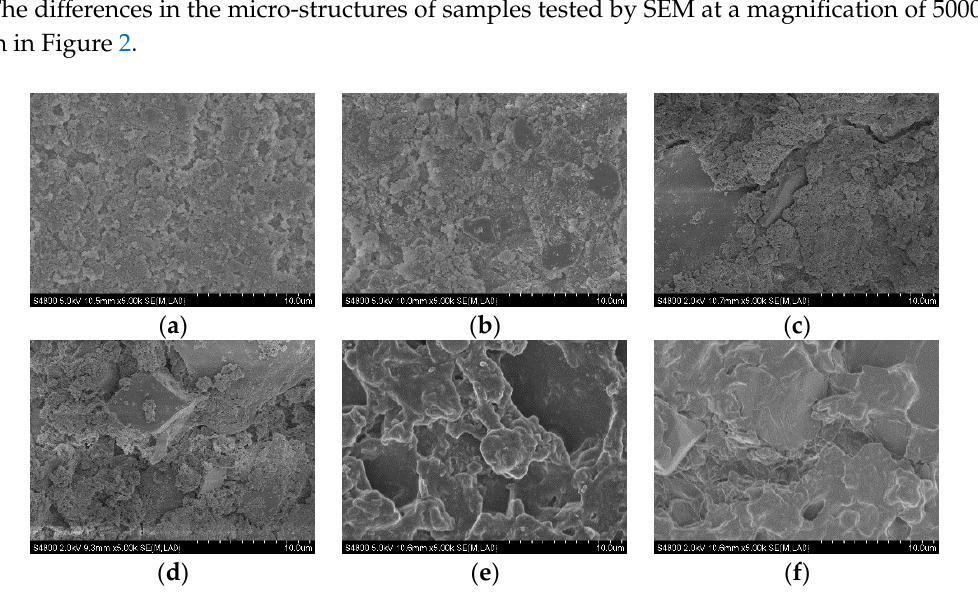
Figure 2. Morphology of samples using scanning electron microscopy (SEM), 5000 × : ( a ) A 1 ; ( b ) A 2 ; ( c ) A 3 ; ( d ) A 4 ; ( e ) A 5 ; ( f ) A 6 .